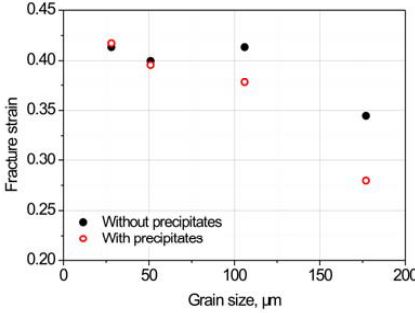
Figure 4. Fracture strains of specimens of different grain sizes with and without precipitates.